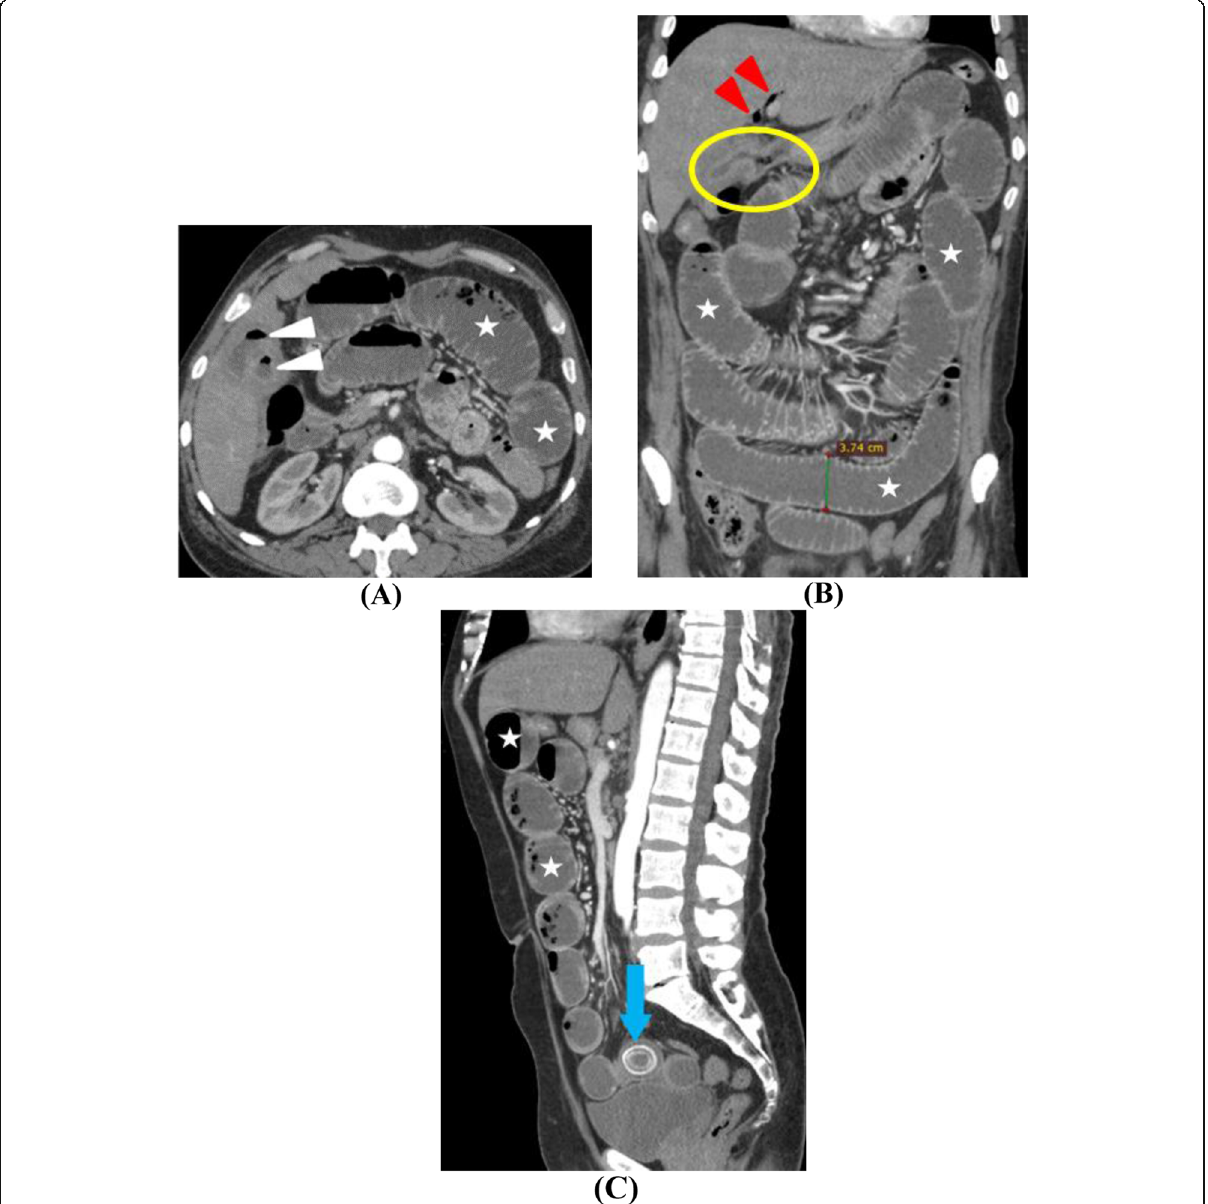
Fig. 8 Gall stone ileus in a 67-year-old male patient presented with acute abdominal pain, fever, and vomiting. Post IV contrast CT abdomen and pelvis ( a ) axial and ( b ) coronal and ( c ) sagittal images showing fistula (circle) between the gall bladder and duodenum with multiple intraluminal air fluid levels seen in the gall bladder (white arrowheads), minimal pneumobilia (red arrowheads) and lamellated impacted stone seen at the proximal ileal bowel loop (arrow) with distended proximal small bowel loops